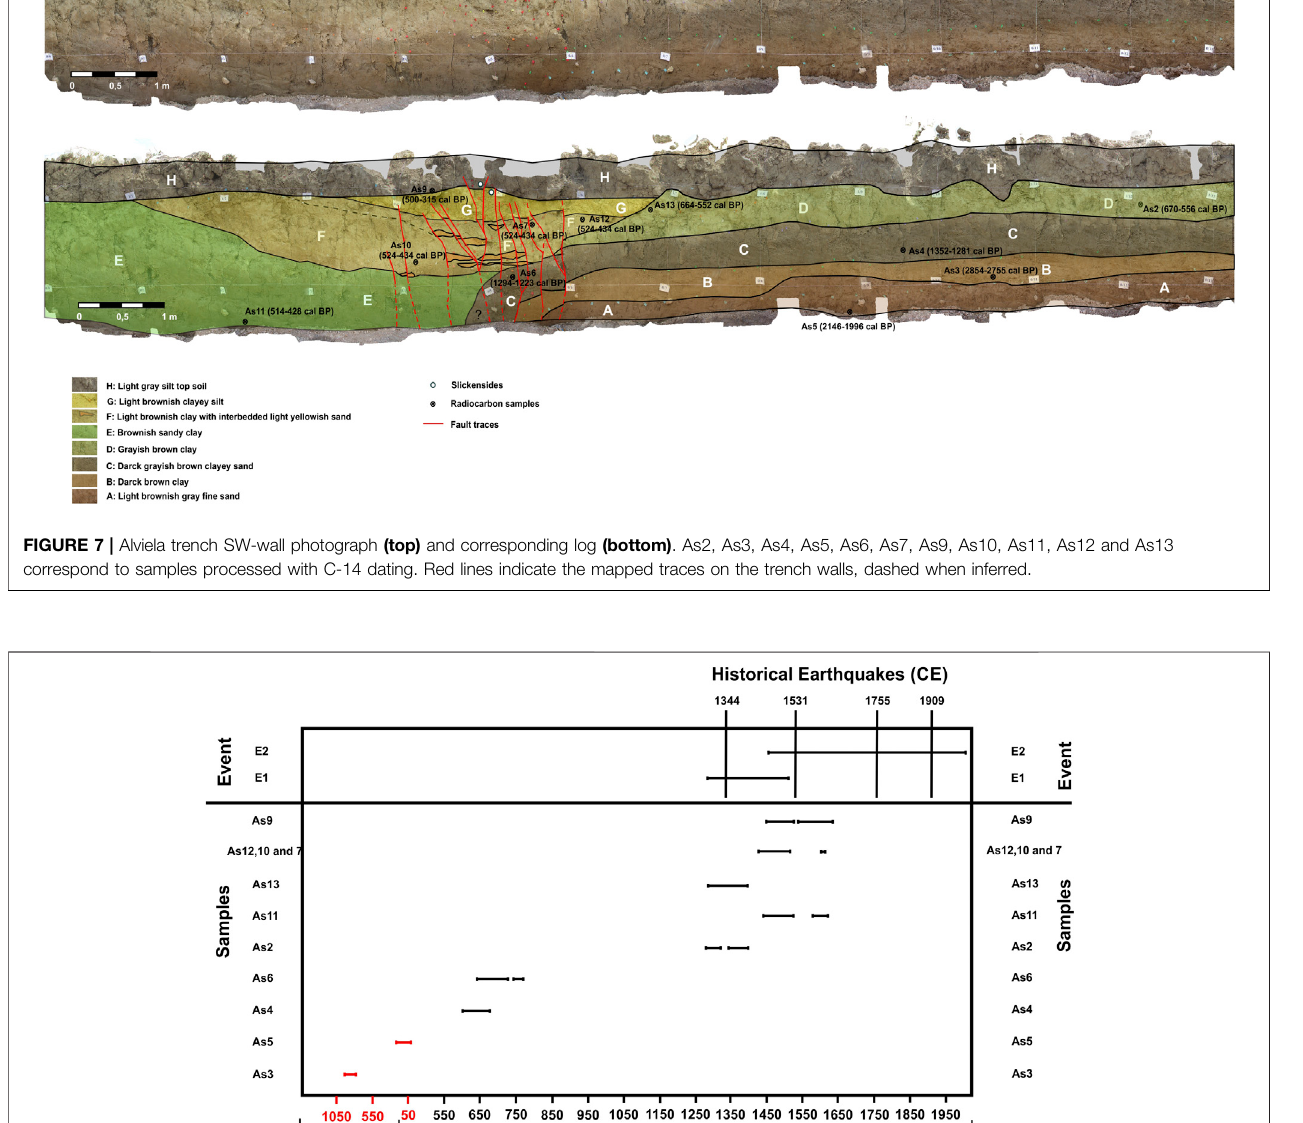
Frontiers in Earth Science |